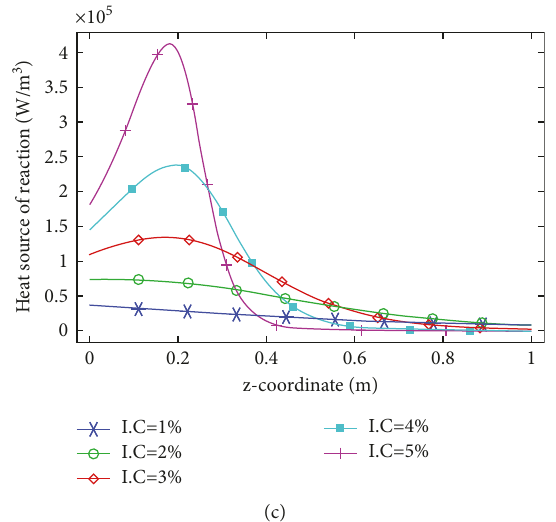
Figure 14: Heat source of reaction: (a) I.C � 1%, E � 75,000J/mol; (b) I.C � 1%, Re � 100; (c) Re � 100, E � 75,000J/mol.